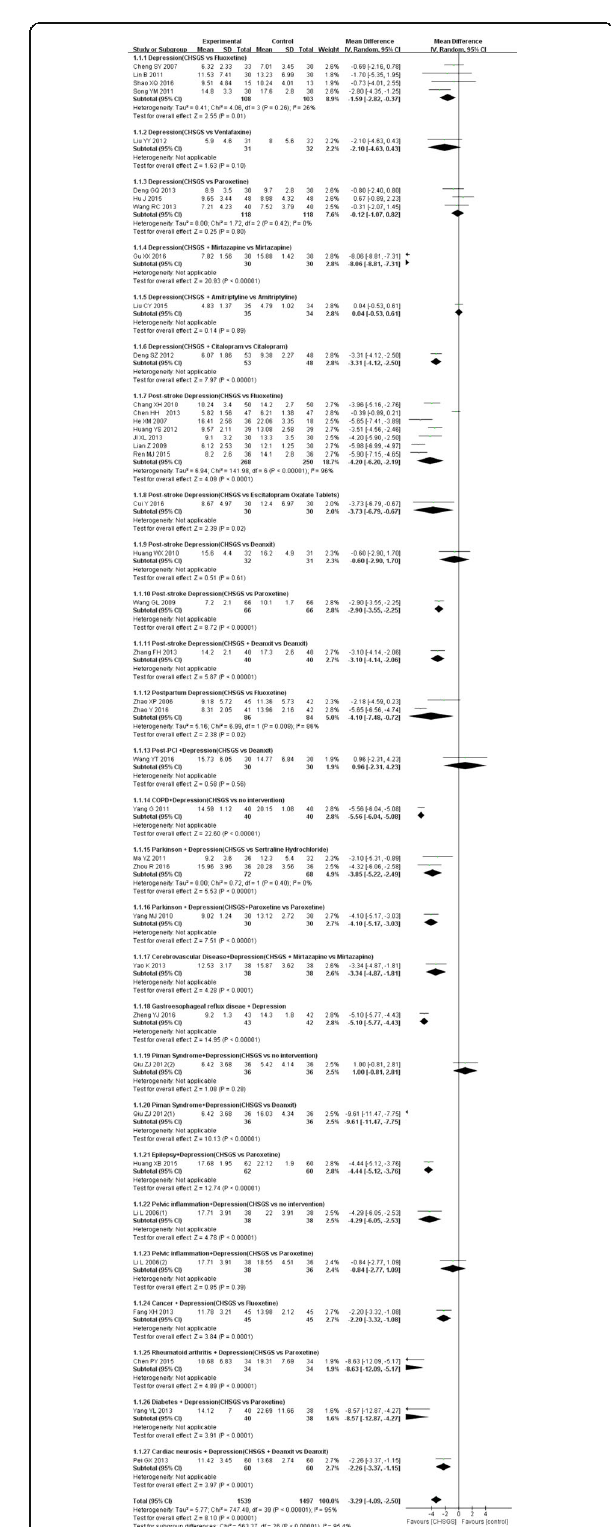
Fig. 2 Risk of bias summary Fig. 3 Forest plot for HAMD improvement after treatment of depression with Chai Hu Shu Gan